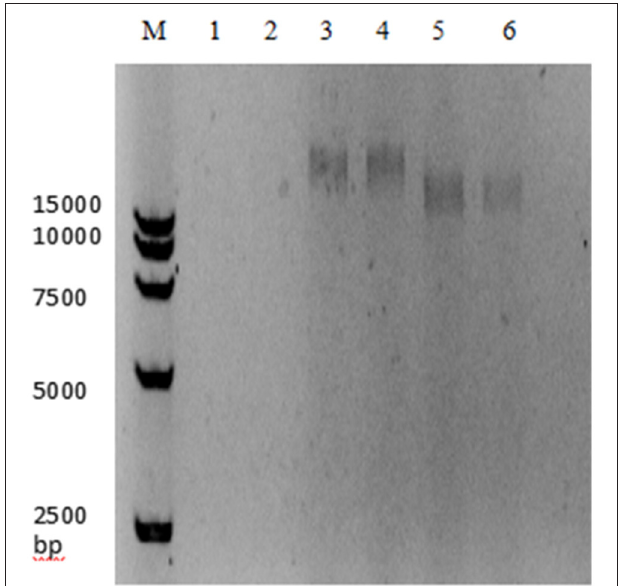
FIGURE 1 | LP8 plaques observed on plate. The host strain was ATCC19111 (1/2a). The plaques, approximately 2mm in diameter, were seen on the plate. (A) is separation plate. (B) is blank plate.